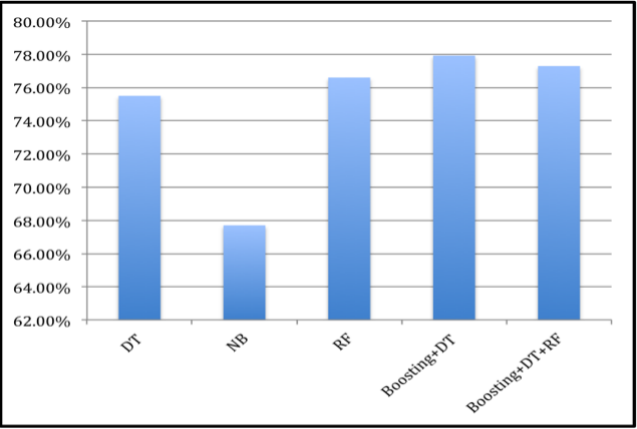
Figure 11. The accuracy of DM techniques and ensemble methods.